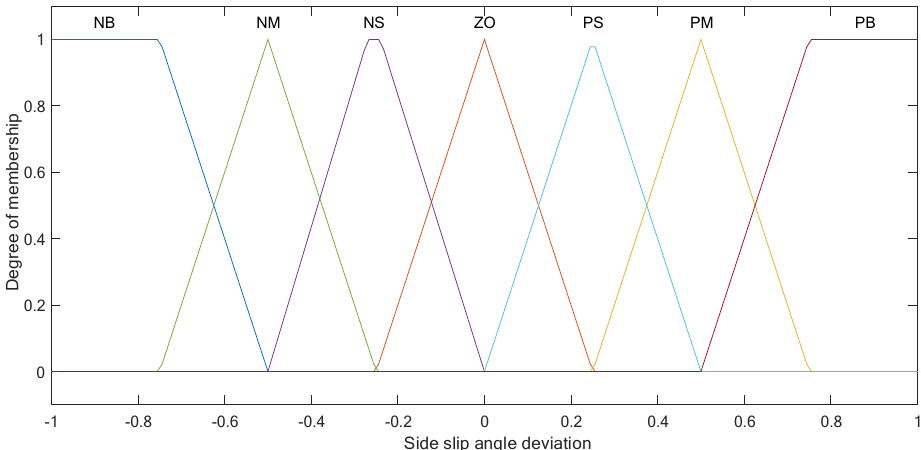
Figure 9. Membership function of the sideslip angle deviation